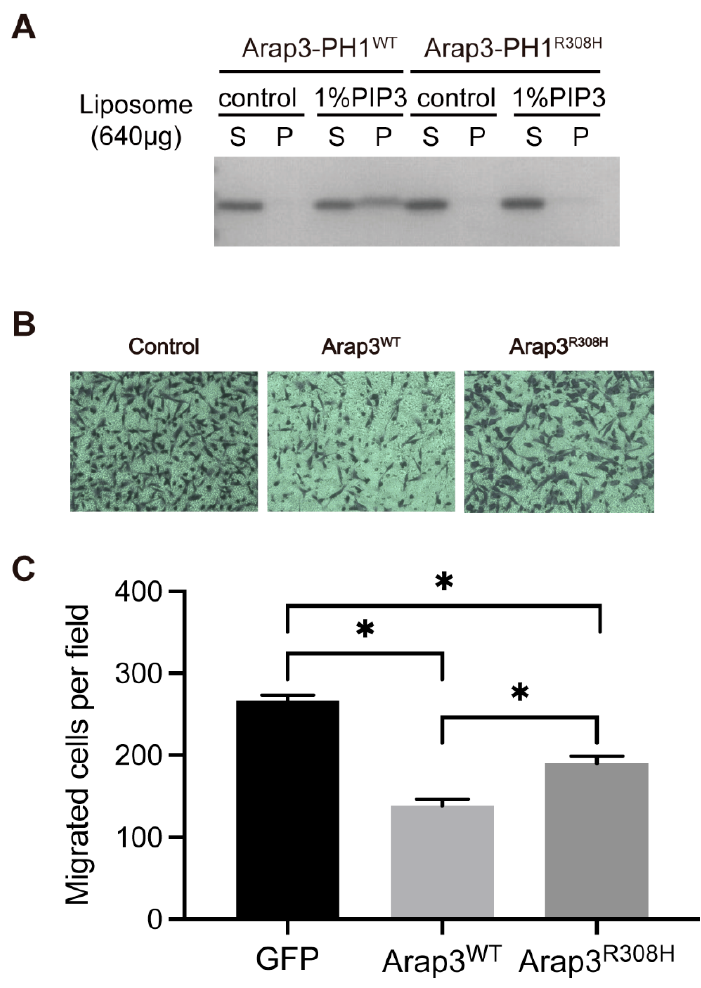
Figure 4. The R308H mutation within the Arap3-PH1 domain abolishes its binding to PI(3,4,5)P3 lipid, and impairs the capacity of Arap3 to inhibit breast cancer cell invasion. ( A ) Liposome binding assays of the Arap3-PH1 R308H mutant with liposomes composed of 99% PC and 1% PI(3,4,5)P3. Arap3-PH1 WT was used as a positive control. ( B ) Transwell migration assays were performed to measure the cell invasion activities of MDA-MB-231 cells transfected with GFP-Arap3 WT , GFP-Arap3 R308H and the GFP control. ( C ) Quantification of cell invasion activities of cells transfected with GFP-Arap3 WT , GFP-Arap3 R308H and the GFP control from the experiment described in ( B ). Data are expressed as mean ± SEM for each group from three independent experiments. * p < 0.05, p values were calculated by Student’s t